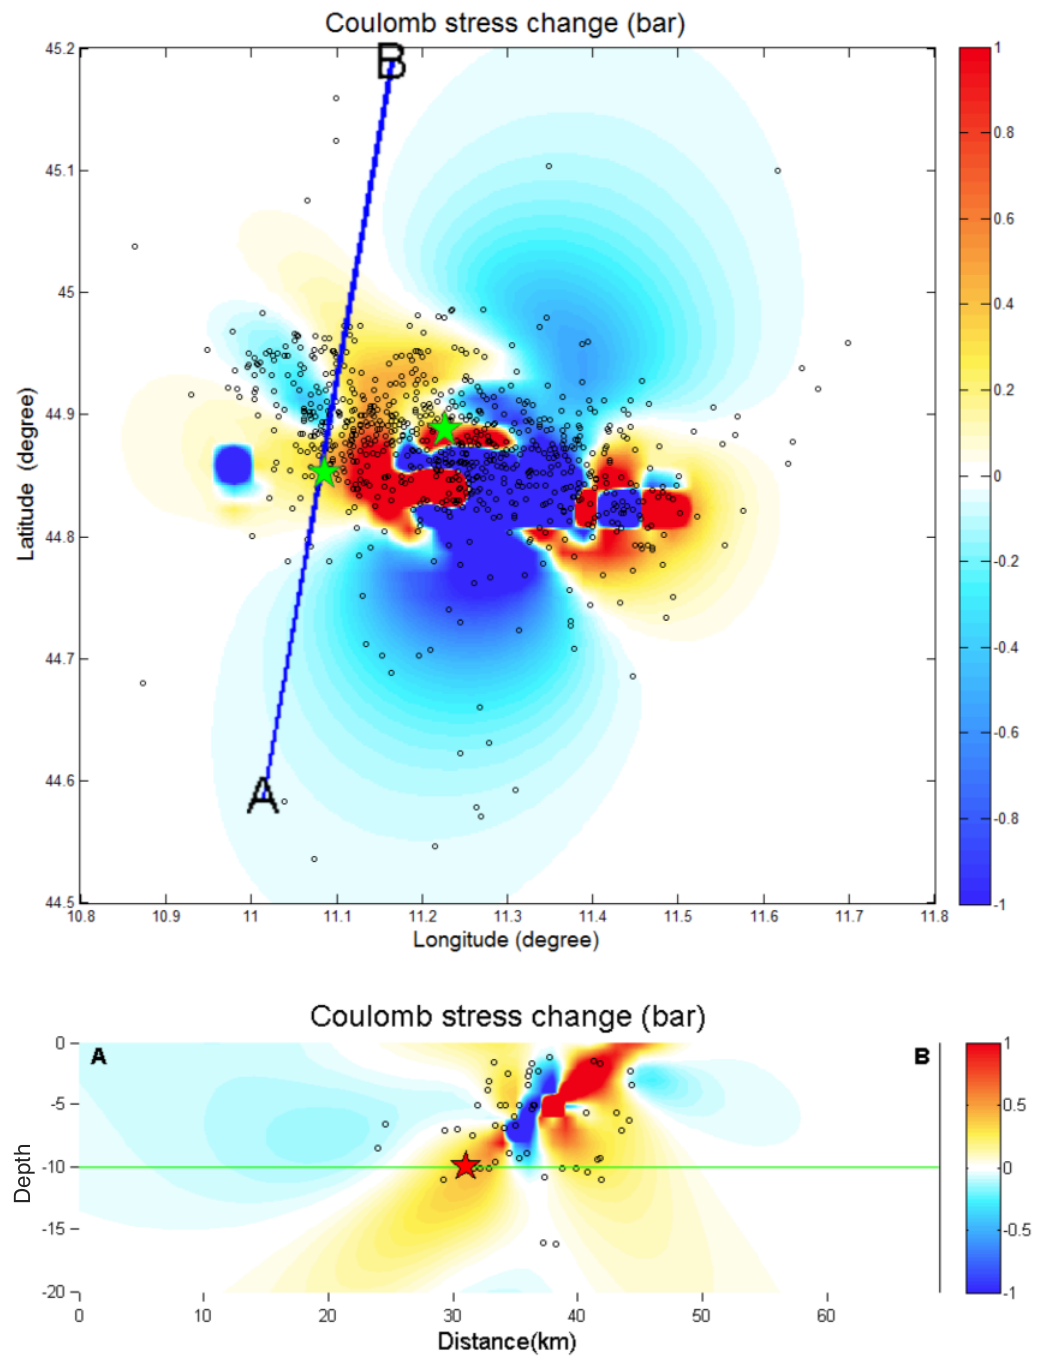
6.1 earthquake. The palette of stress values is linear W